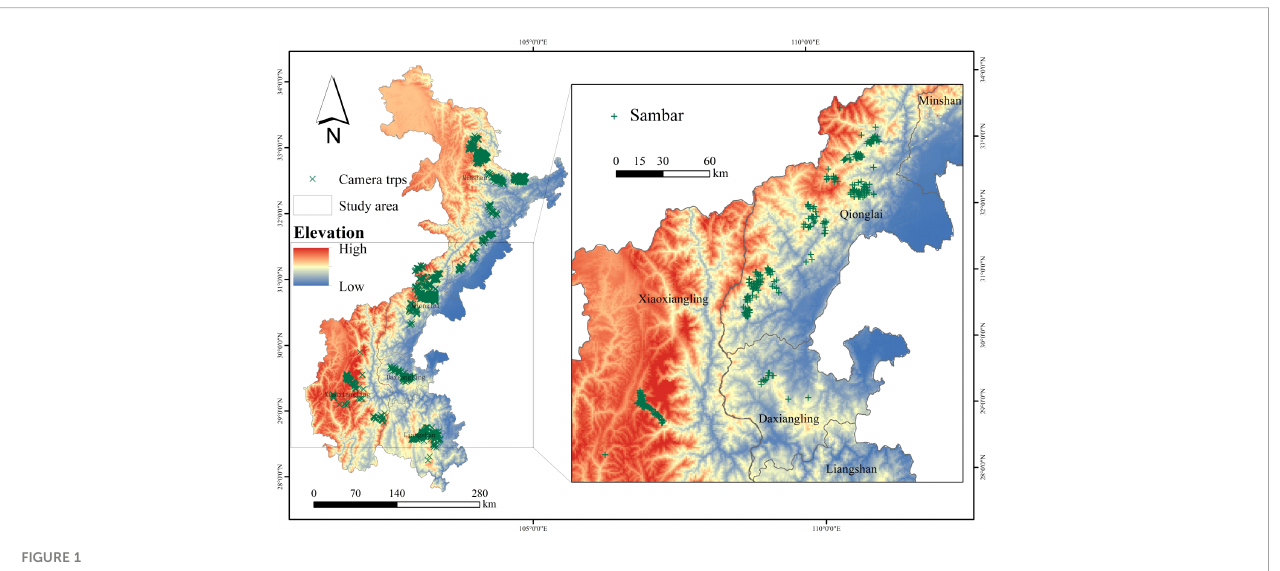
FIGURE 1 Camera traps and sambar in the study area.